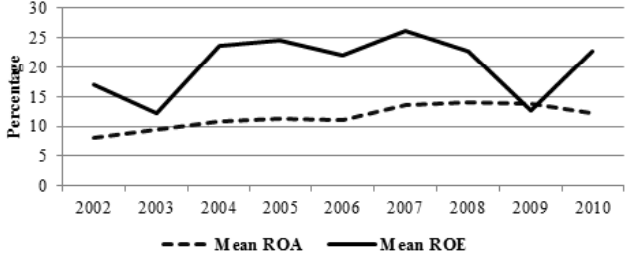
Figure 2: Mean profitability ratios (%) Perusal of Figure 2 shows that the annual mean ROE values were higher than the corresponding ROA values (except for 2009), possibly owing to financial leverage. The decreasing trend in the mean ROA and ROE ratios between 2008 and 2009 were not surprising, since South Africa experienced a recession in the first semester of 2009. Figure 3 illustrates the trend in the mean annual EPS (nominal values; cents per share) and TSR (%) between 2002 and